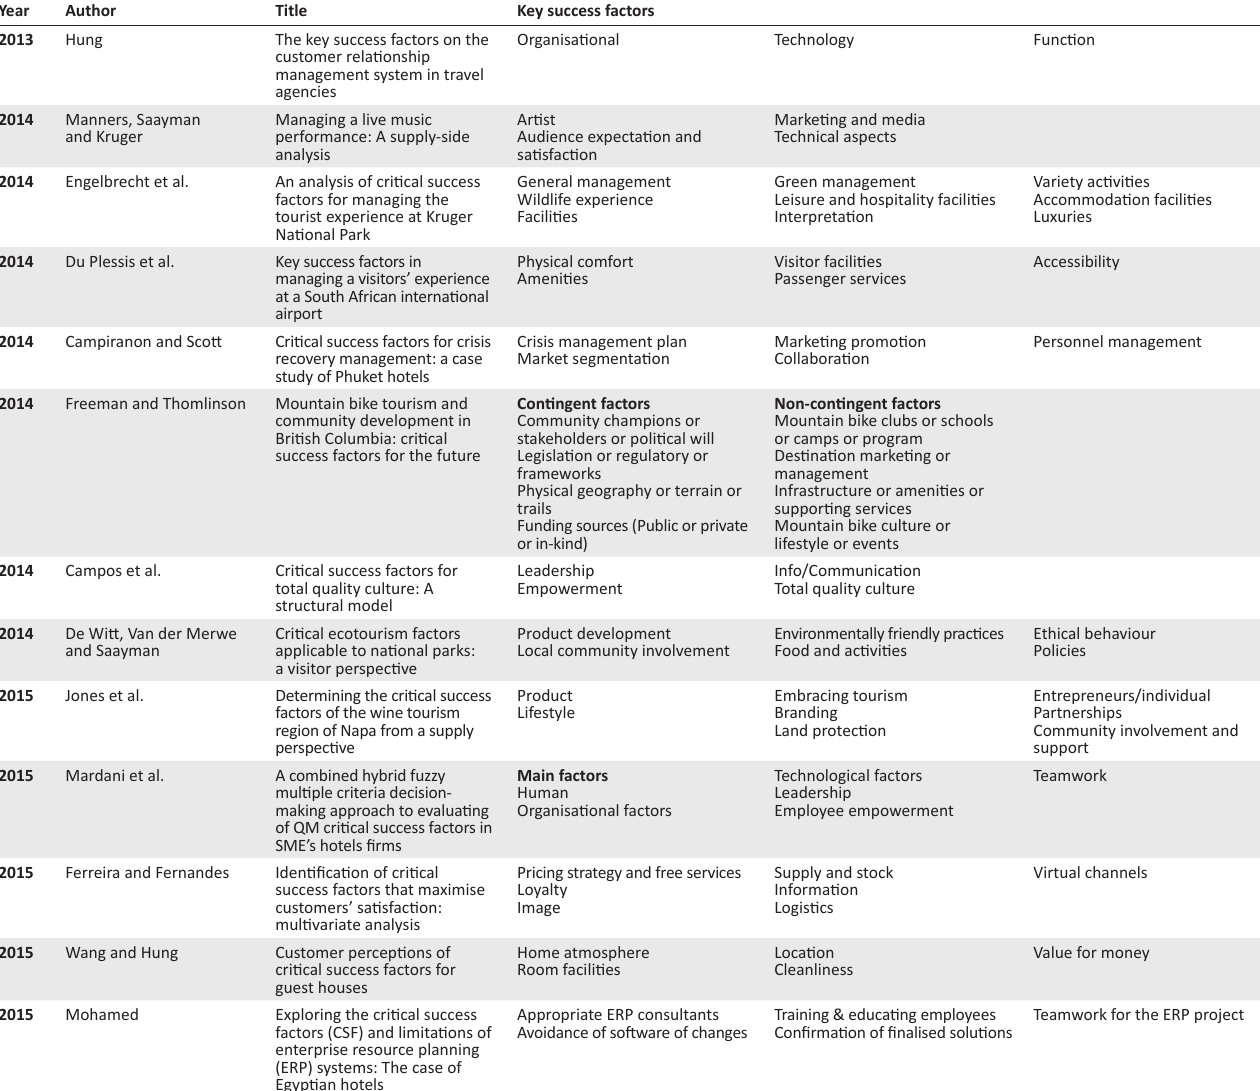
FIGURE 1 (Continues…): Previous published studies on critical success